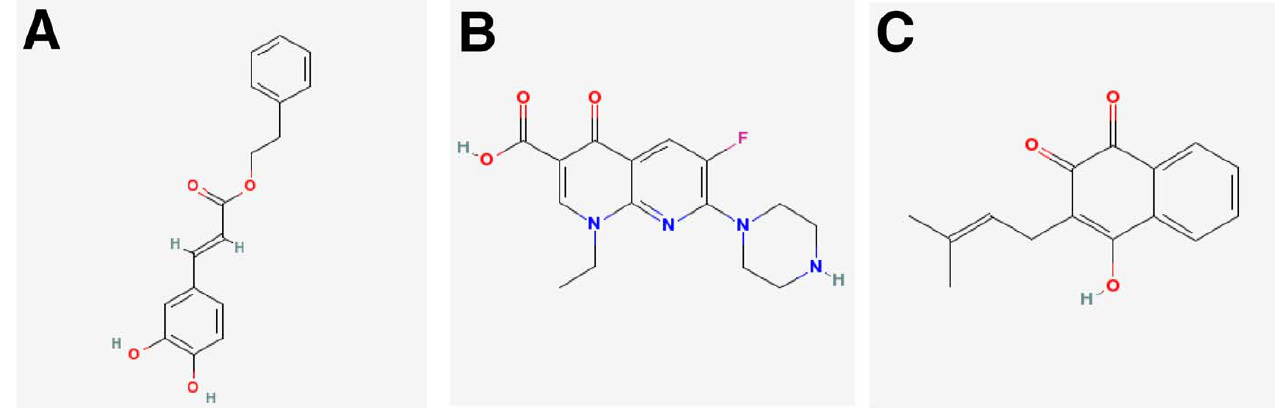
Figure 8. Chemical Compounds Identified Using the C. elegans–Candida Screen Tested in a Murine Model of Hematogenous Candidiasis